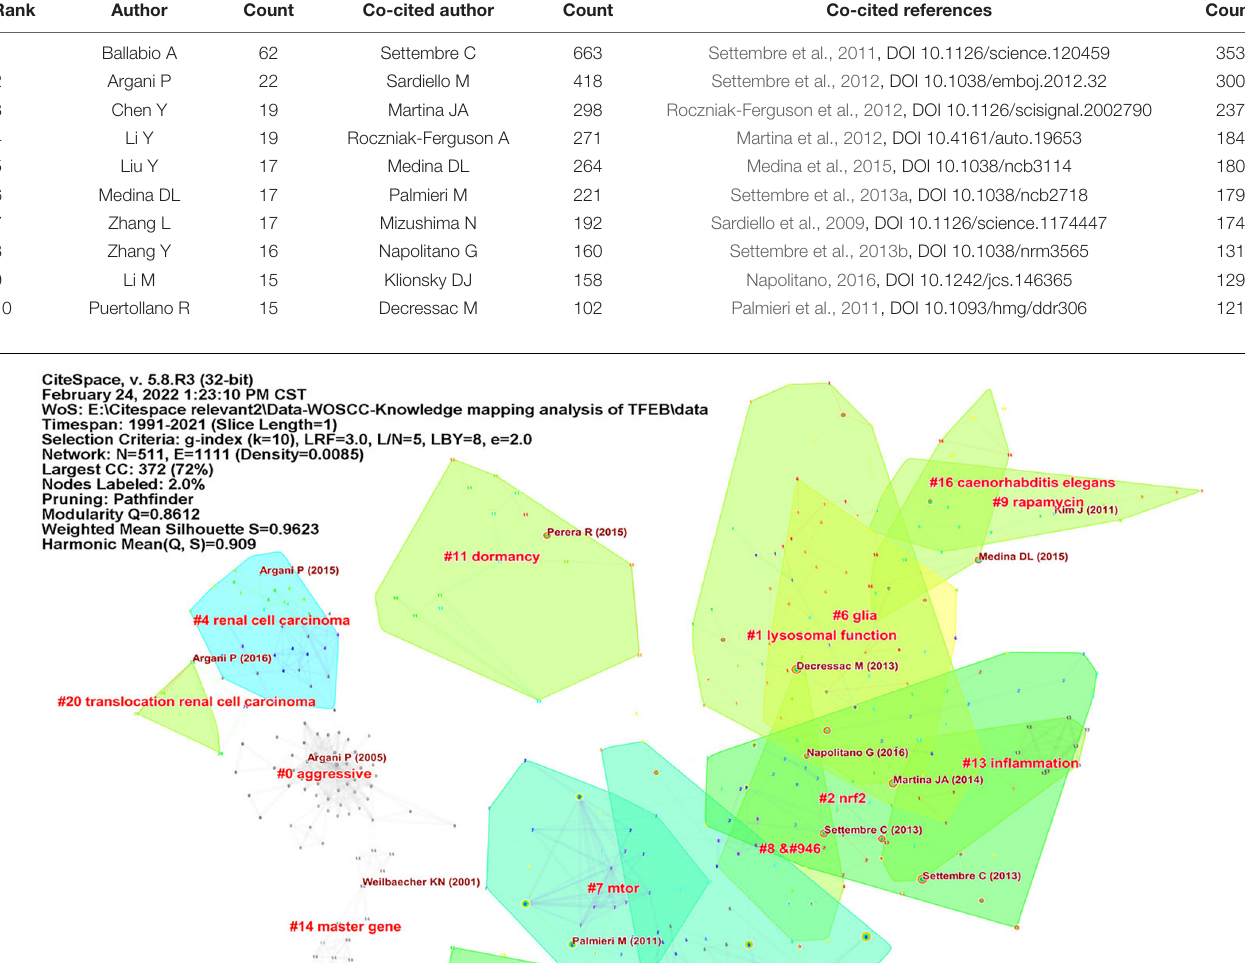
TABLE 4 | The top 10 authors, co-cited authors and co-cited references.